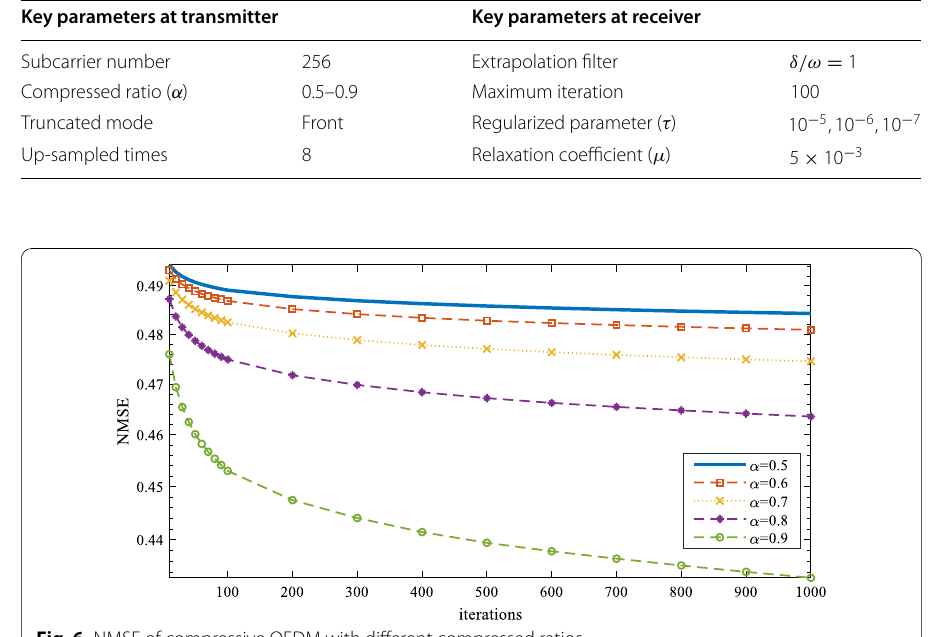
Fig. 6 NMSE of compressive OFDM with different compressed